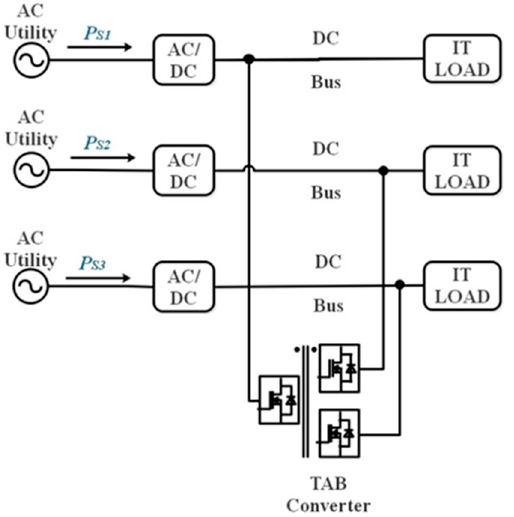
Figure 2. Diagram of a DC power distribution system in a data center using the triple active bridge (TAB) converter in a DC microgrid.